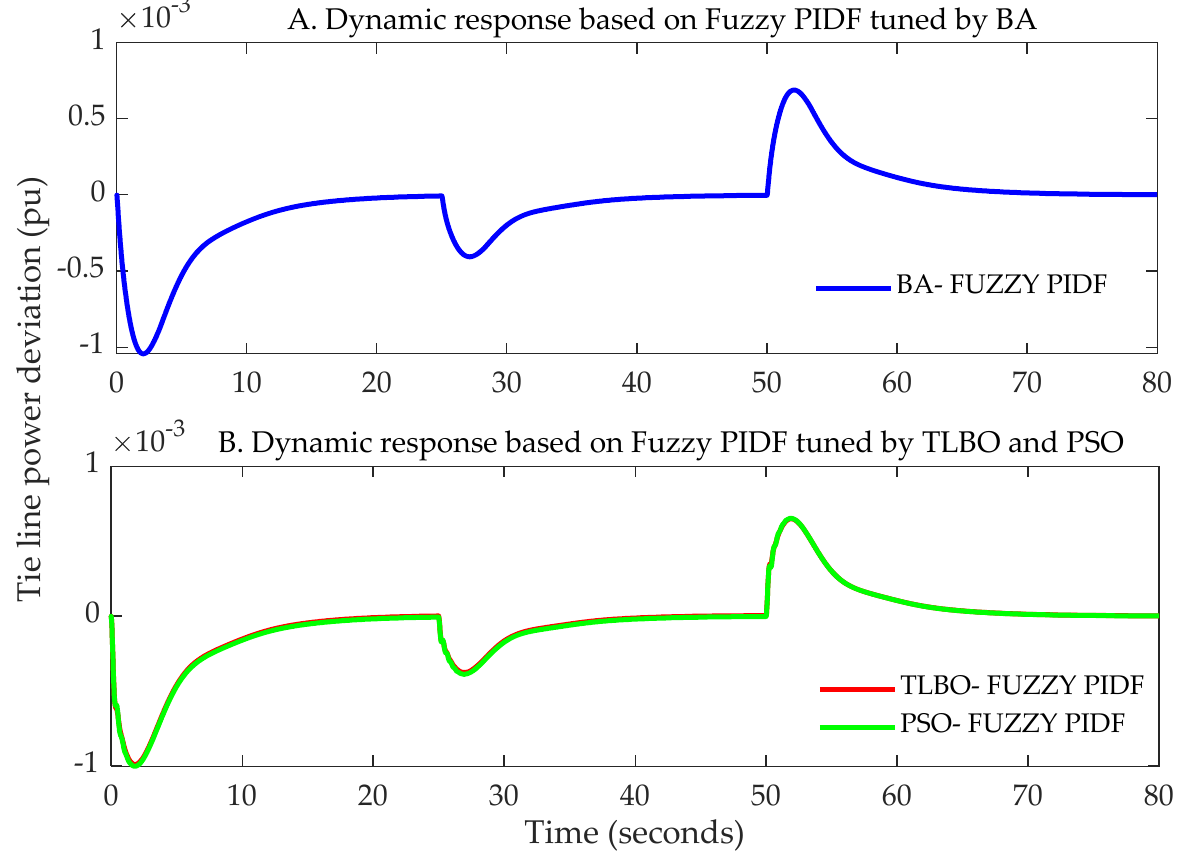
Figure 15. Tie-line power deviation ( ∆ P tie in pu): ( A ) based on BA tuning and ( B ) based on TLBO and PSO tuning.